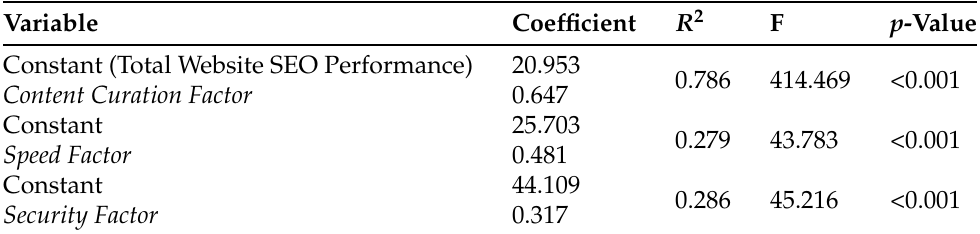
Table 7. Regression equation output of websites with Custom CMS and their change in each proposed factor.